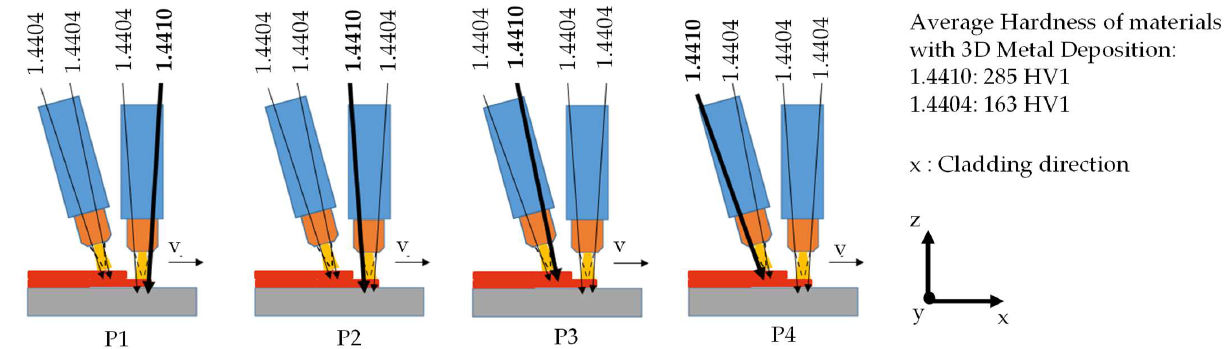
on [4]) for each position. Figure 6. Powder feeding positions related with powder material 1.4410 (average hardness based